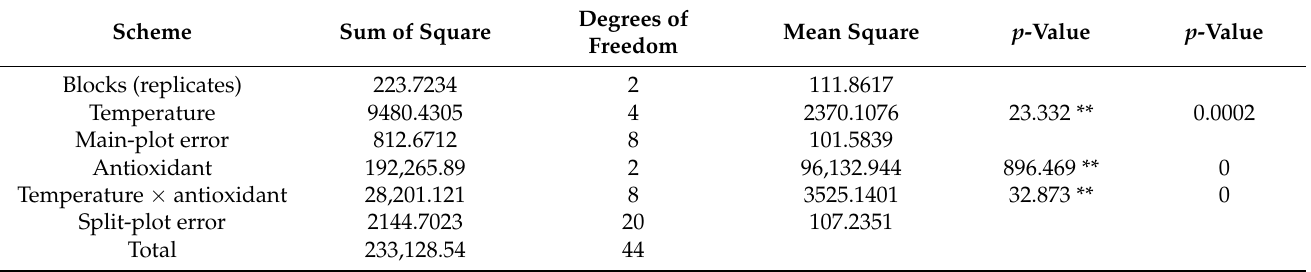
Table 2. Split-plot analysis of variance for S. maximus temperature resistance experiment, with five temperature gradients and three antioxidant enzymes.